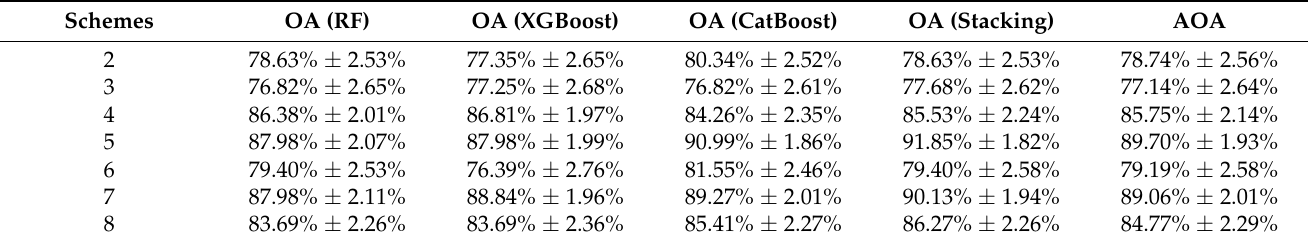
Table 7. Overall accuracy and standard errors of the models in different classification schemes using C-band and L-band quad-polarization SAR images. OA, overall accuracy; AOA, average overall